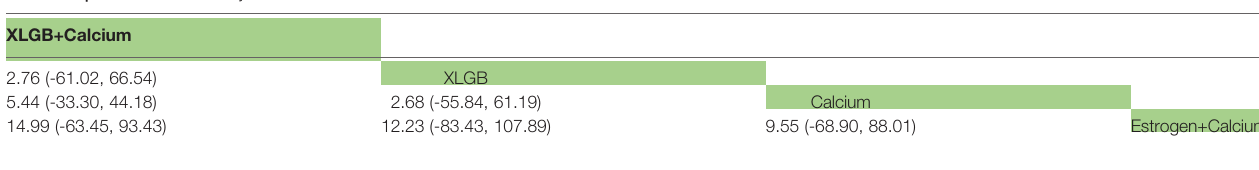
TABLE 9 | Network meta-analysis of ALP.